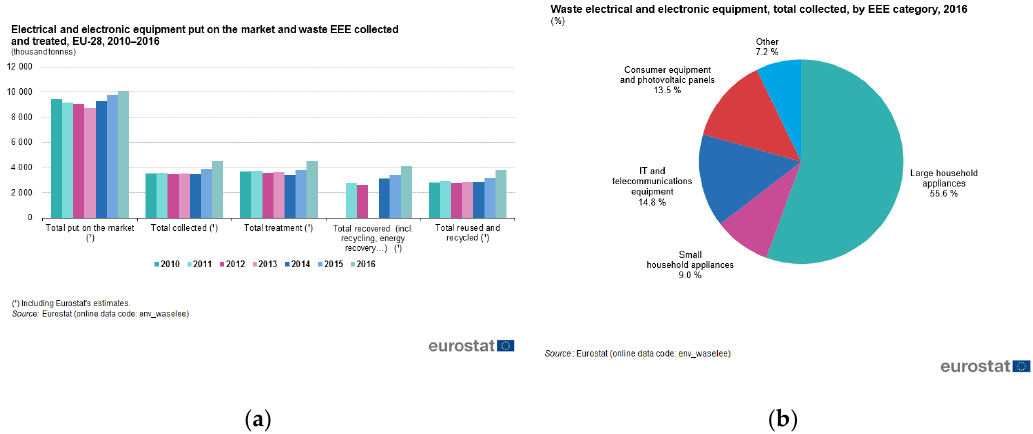
Figure 1. ( a ) EEE put on the market, collected waste and treated waste, EU–28, 2010–2016 [7]; ( b ) WEEE, total collected by EEE category, 2016 [7].